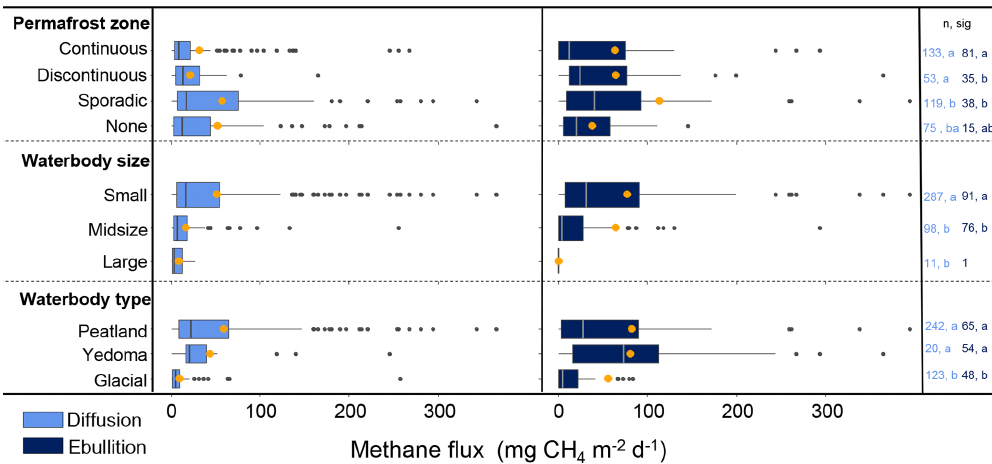
Figure 11. Ice-free season diffusion (left) and ebullitive (right) CH 4 fluxes as described by categorical variables. Orange circles represent mean flux values. The number of sites for each category is represented in the column to the right ( n ) in the representative colours for diffusion (light blue) and ebullition (dark blue). The letters (sig) indicate statistical differences among the categories, wherein bars with the same letters are not significantly different. Lake size represents binned surface areas for < 0.1km 2 (small), 0.1–10km 2 (midsize), and > 10km 2 (large). Lake type represents the BAWLD classification of waterbody types including Peatland, Yedoma , and Glacial Lakes . Fluxes higher than 380 are not